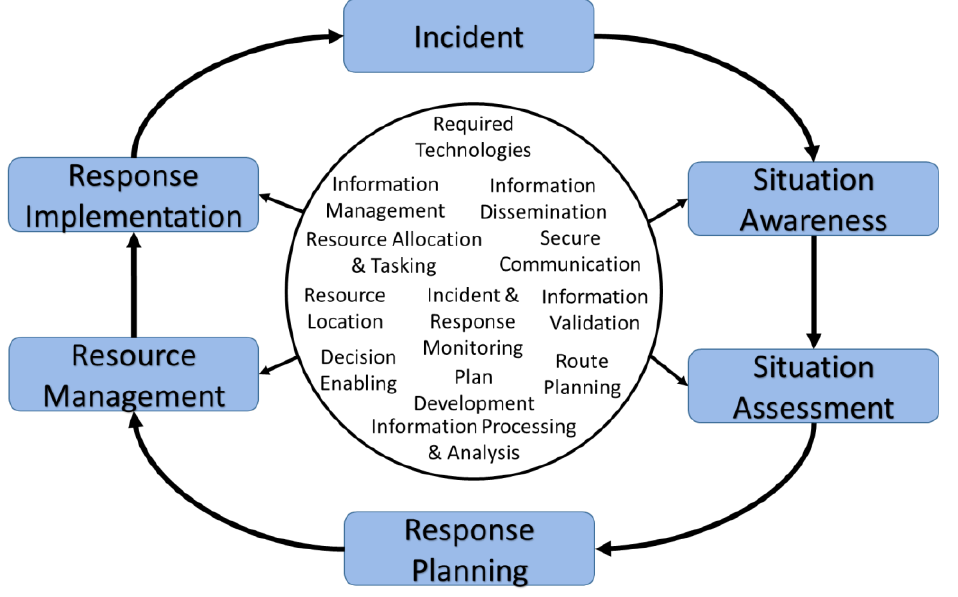
Figure 1. Incident and crisis management response